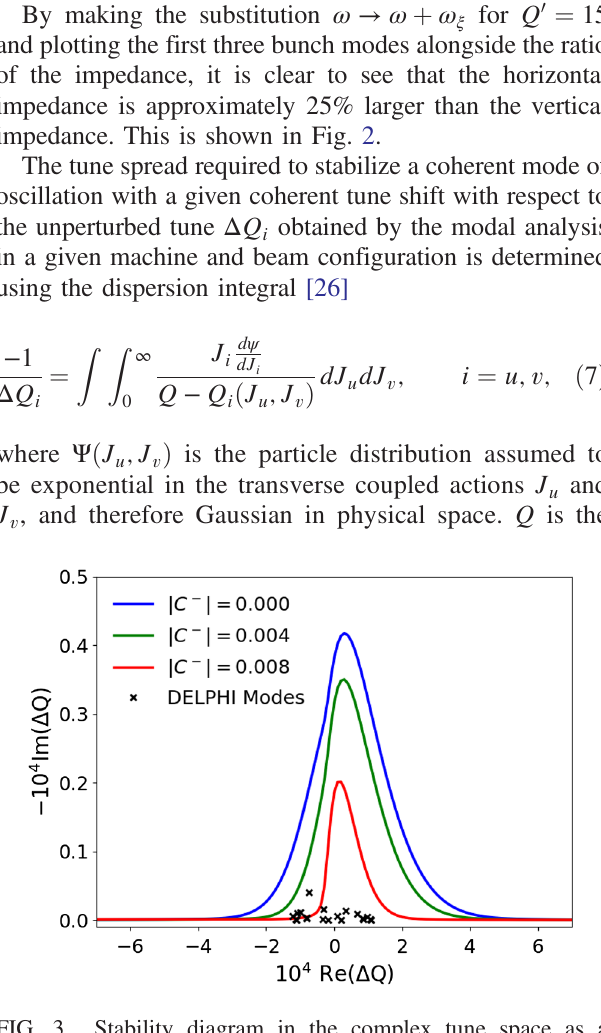
FIG. 3. Stability diagram in the complex tune space as a function of different values of j C − j plotted alongside the complex coherent modes from DELPHI. As the coupling is increased, some previously stable modes lie outside of the stable region and Landau damping is lost. The coupled tunes are kept constant with Q ¼ 0 . 31 and Q ¼ 0 . 32 u v